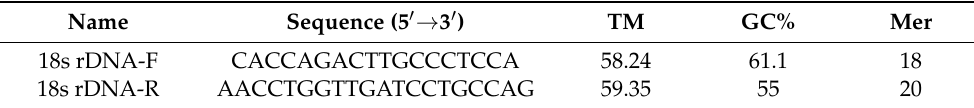
Table 1. Sequence of primers used in the